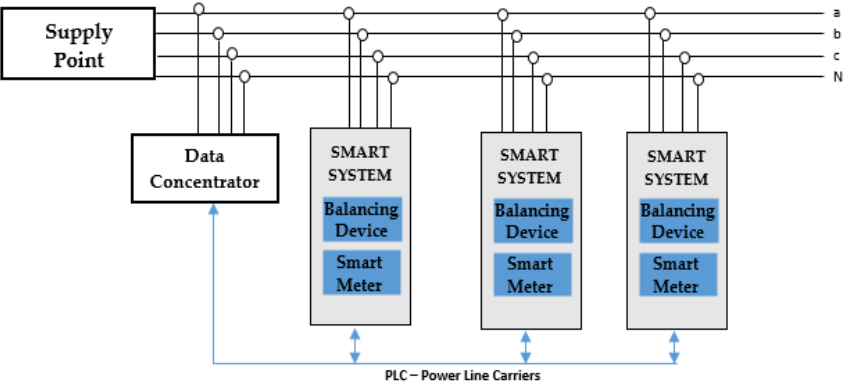
Figure 2. The structure of a smart phase load balancing system (SPLBS) installed at the consumers integrated in the smart metering system (SMS).